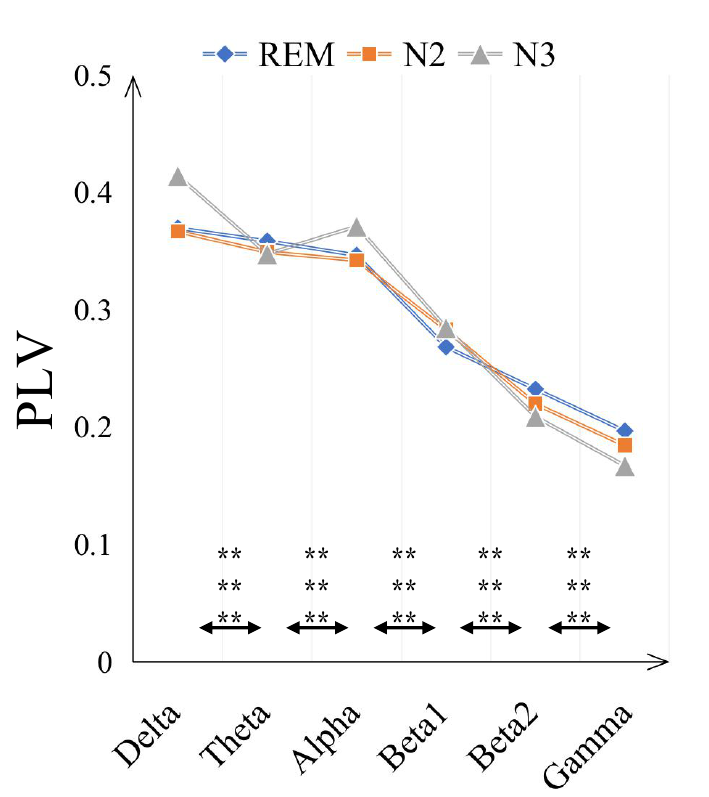
Figure 5. The averaged PLV value of three sleep stages in six frequency bands to observe the PLV distribution in different frequency bands. The double-asterisk ‘**’ indicates that there is a significant difference of p < 0.001 by ANOVA test and three rows represent the significant difference result between two frequency bands for ’REM and N2’, ’REM and N3’ and ’REM and N2’